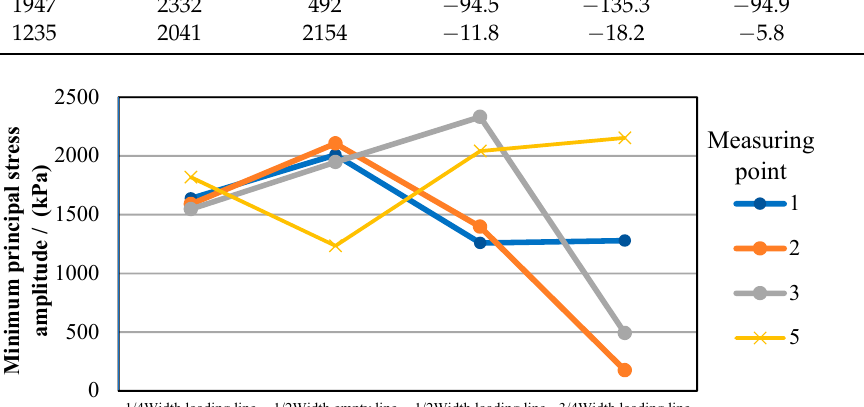
Figure 18. Minimum principal stress amplitude diagram of measuring points 1, 2, 3, and 5 under different basement hanging ranges.